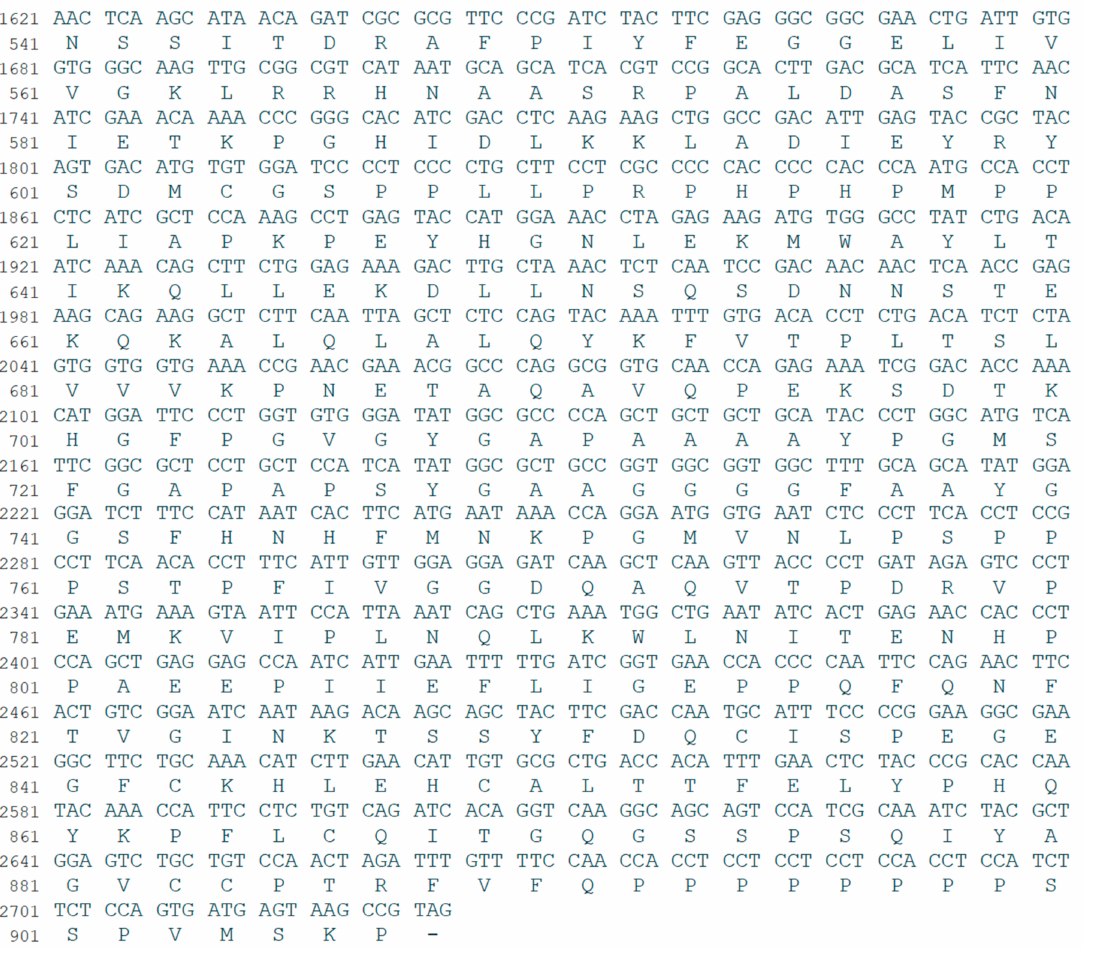
Figure 1. Nucleotide and encoded amino acid sequences of NlITIH4 ORF. The signal peptide is indicated by a box. The vault protein inter-alpha-trypsin domain is underlined with a dotted line, and the von Willebrand factor type A domain is underlined with a solid line.